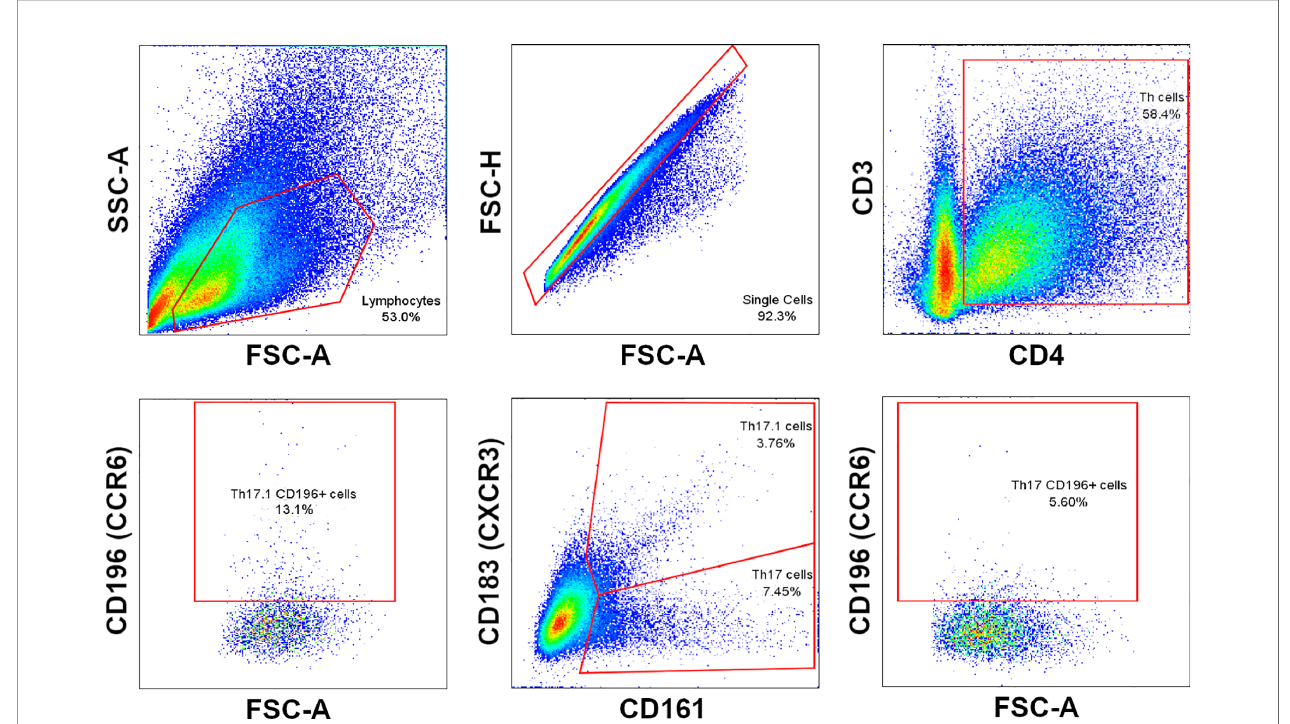
FIGURE 2 | Cell gating strategy to identify Th17 and Th17.1 cell